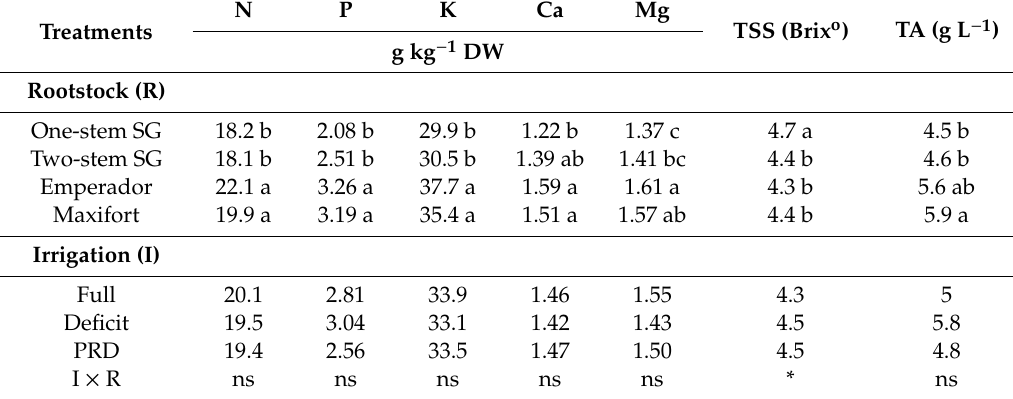
Table 7. E ff ect of rootstock type and irrigation treatment on tomato fruits mineral concentrations and quality parameters in the second year of the experiment with plants grown on one and two stems.